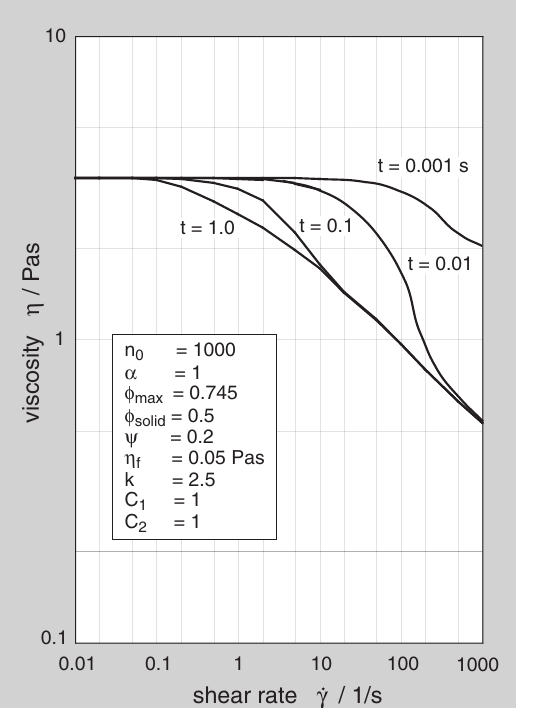
Figure 8 (left): Calculated shear time dependency of viscosity functions from FIM model. Figure 9: Calculated viscosity functions for various immobilization ratio y from FIM model.